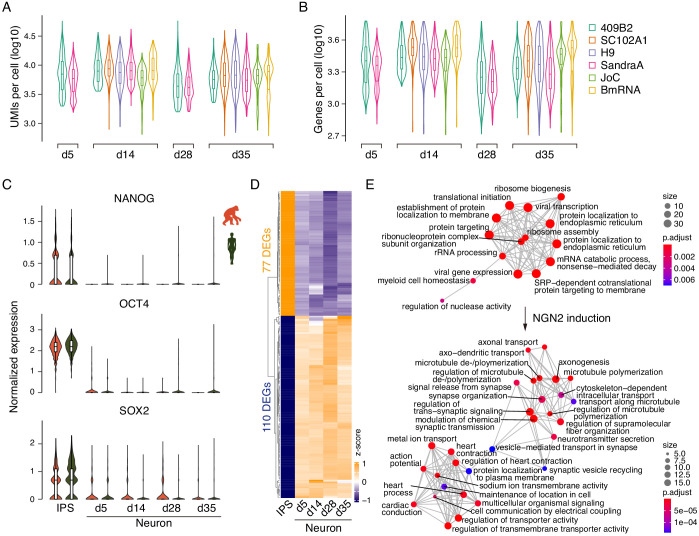
Downregulation of stem cell markers in iNs.(A,B) The violin plots show number of UMIs (A) and genes (B) per cell per cell line and time point of iN differentiation. (C) The violin plots show the expression in iPSCs and iNs at d5, d14, d28, and d35 of three stem cell marker genes (NANOG, OCT4, and SOX2) in apes (orange) and humans (green). All stem cell genes show a reduction in their expression at the transition from iPSCs to neurons. (D) Differences in gene expression between the different time points of iN differentiation and the stem cells. (E) Networks of enriched GO biological processes in the stem cells and iNs are shown in the top and bottom panels, respectively.